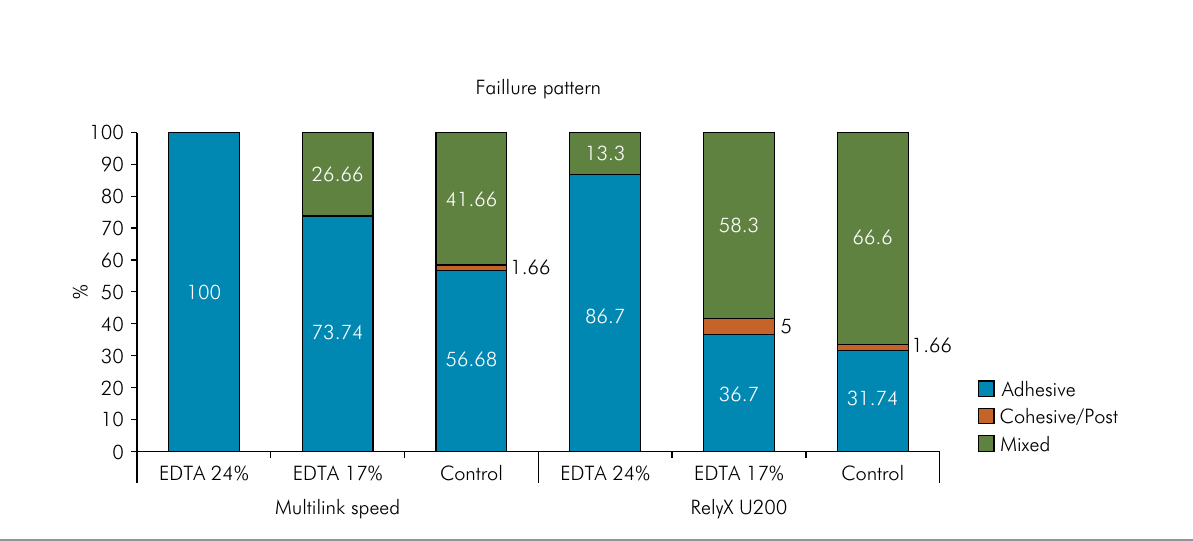
Figure. Representative graph of the fracture patterns observed after bond strength testing for the different experimental